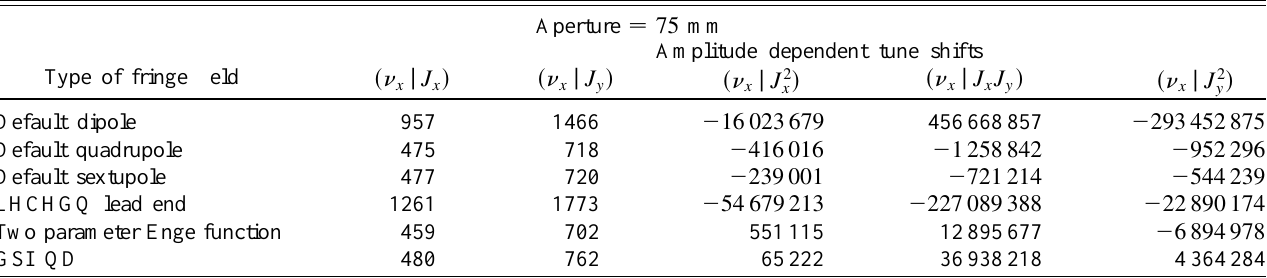
TABLE VI. A few amplitude dependent tune shifts for the 75 mm aperture case. All six of the studied fringe field fall-off shapes are included.